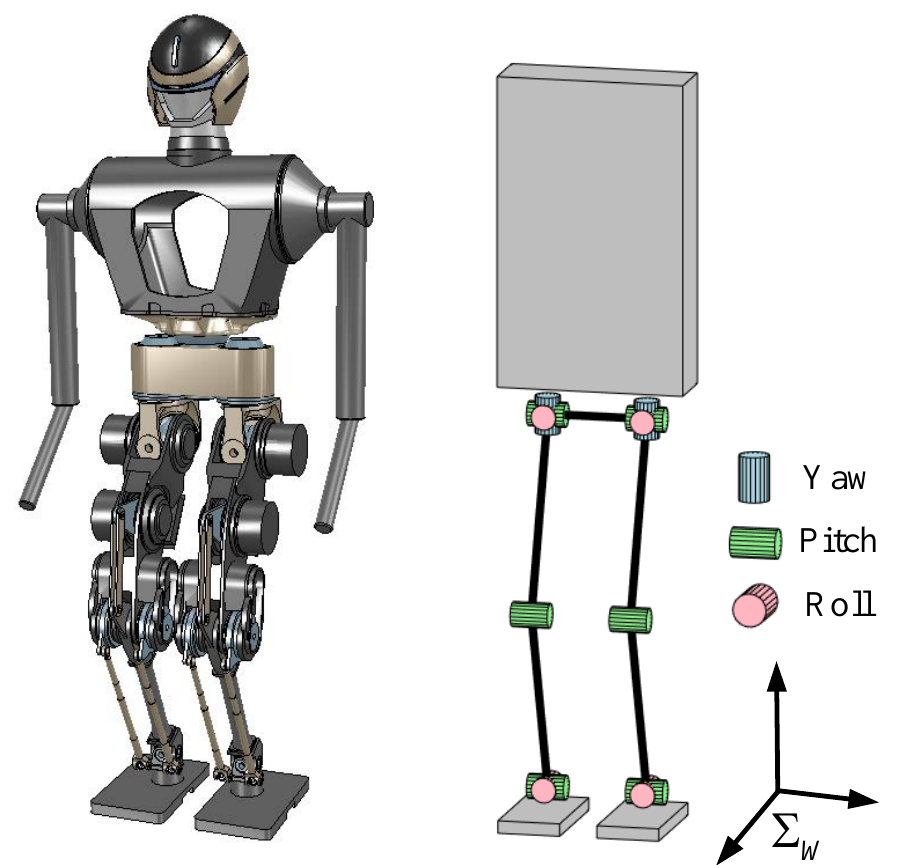
Figure 5. Bipedal robot BHR7P and its